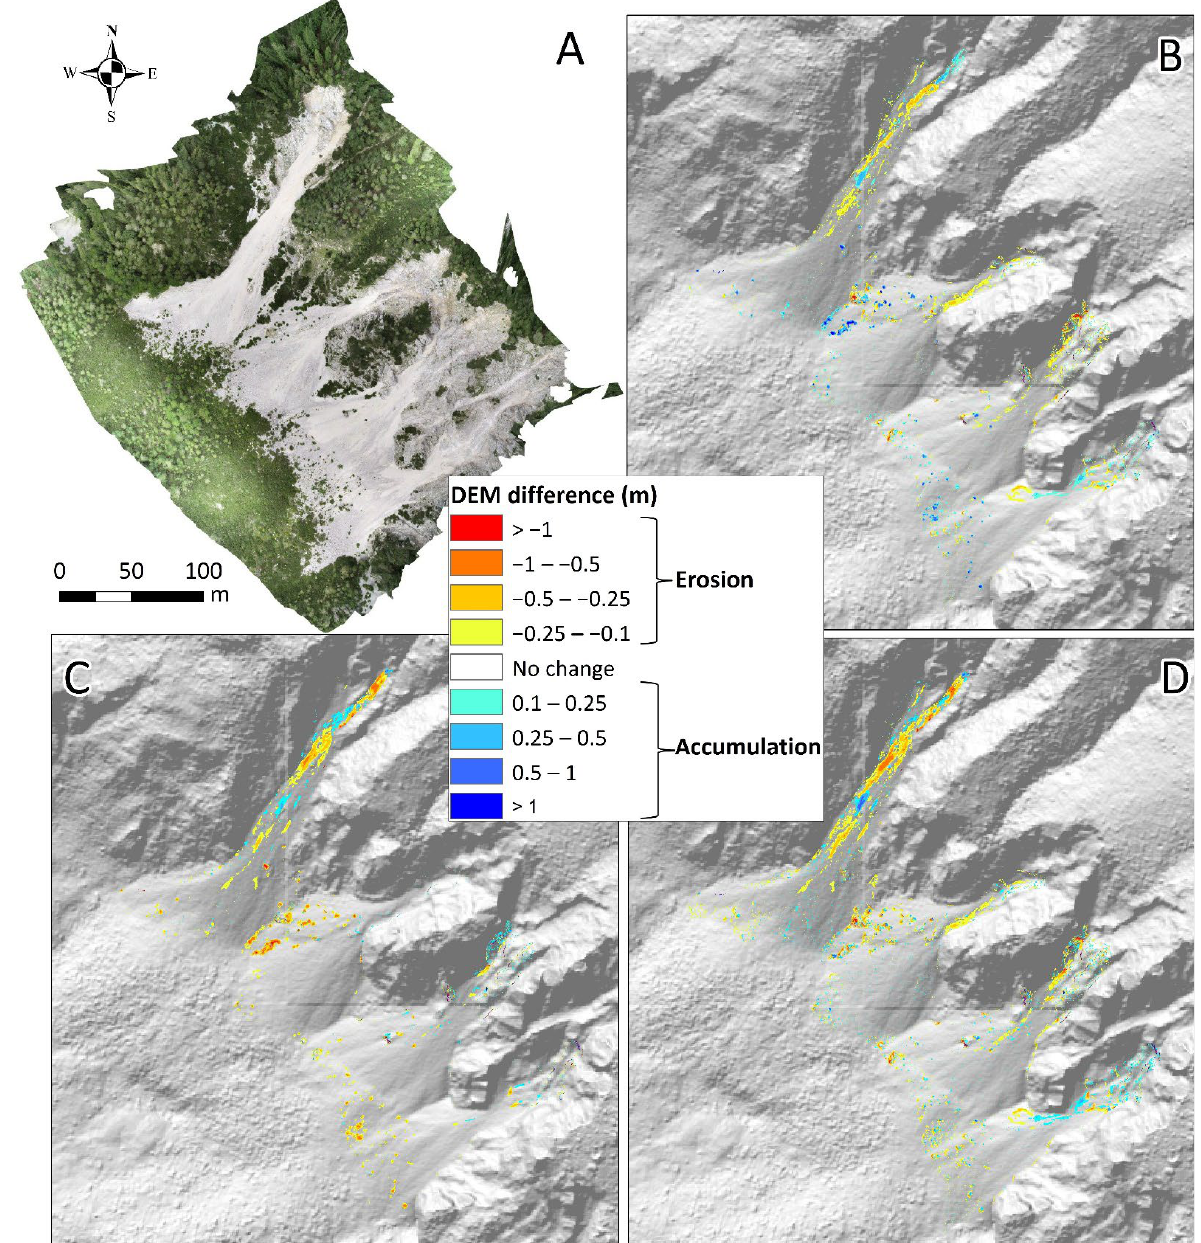
Figure 9. ( A ): Orthophoto of a steep slope above the Urbas landslide obtained by unmanned aerial vehicle (UAV) photogrammetry in May 2020; ( B ): DEM difference (DoD) between August 2019 and